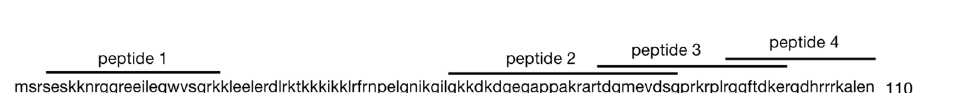
Table 5. HDAg peptide reactivity of RNA positive samples. Individual peptides were used in the indirect IgG assay. Shown are signal to noise (S/N) values for each peptide. A S/N value > 10 is considered